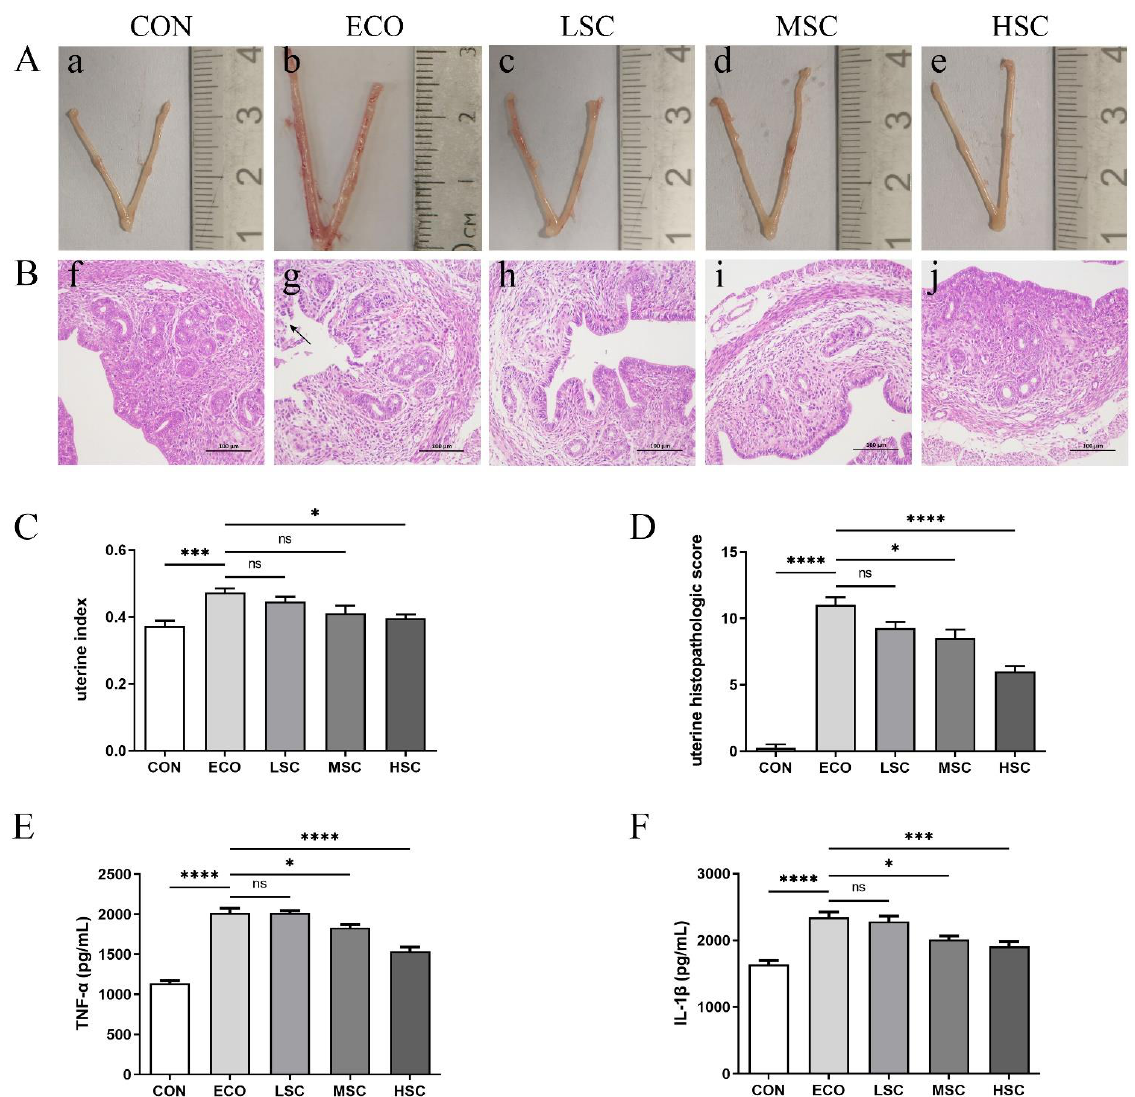
Figure 6. C. butyricum culture supernatant relieved the uterine tissue inflammatory response induced by E. coli in a concentration-dependent manner. ( A ) Mouse uterus morphology (( a ) CON; ( b ) ECO; ( c ) LSC; ( d ) MSC; ( e ) HSC). ( B ) H&E staining of uterine tissue (( f ) CON; ( g ) ECO; ( h ) LSC; ( i ) MSC; ( j ) HSC). ( C ) Uterine index. ( D ) Histopathologic scoring of the uterine tissue. ( E ) Uterine tissue TNF- α . ( F ) Uterine tissue IL-1 β . The values presented are the means ± SEM ( n = 3). * p < 0.05, *** p < 0.001, and **** p < 0.0001 are significantly different from ECO group.